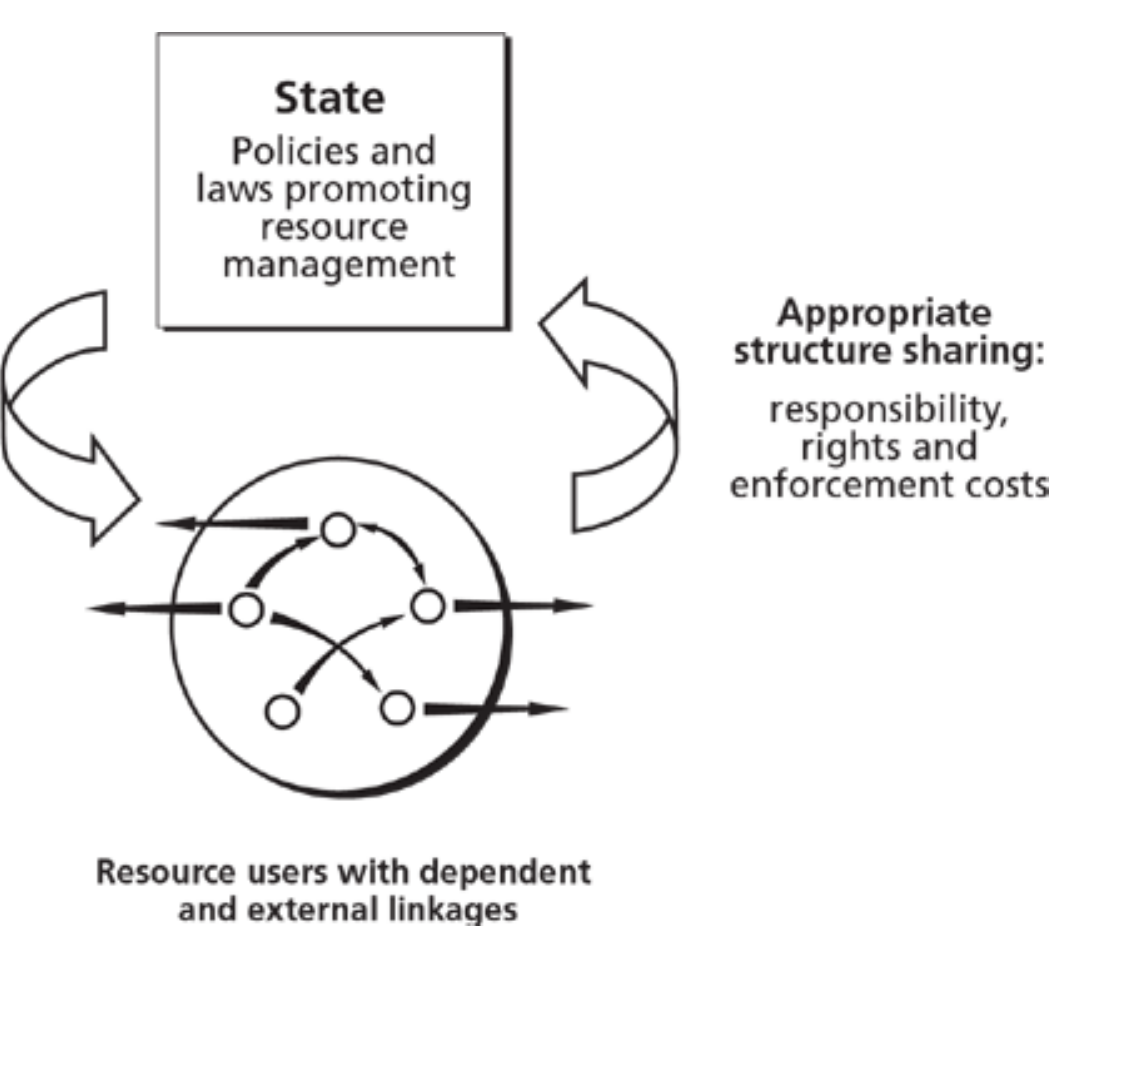
Figure 2 . Interactions between government and civil society in co-management